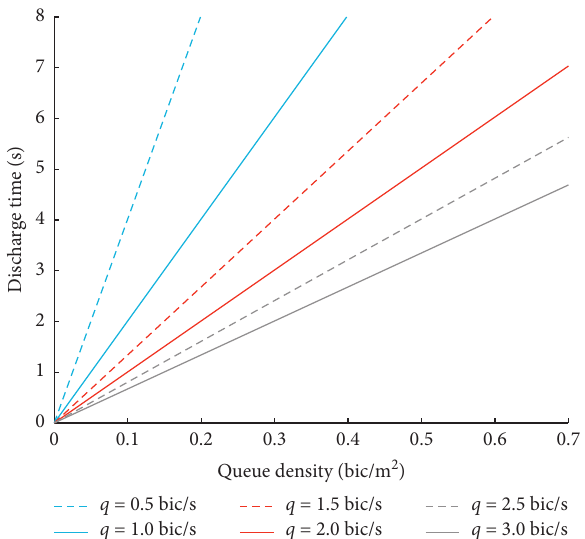
Figure 2: Template to visualize the relation between jam density and queue discharge